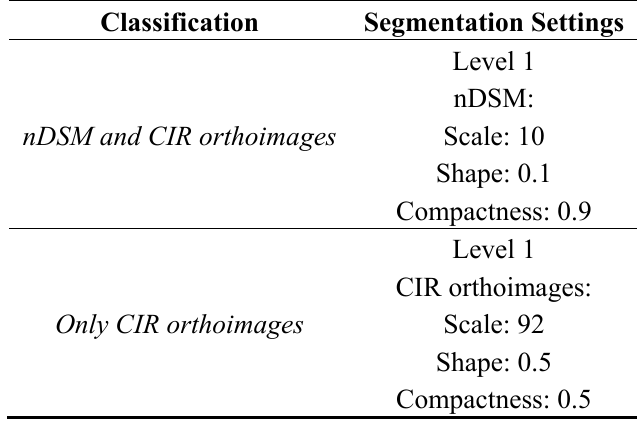
Table 1. Overview of the multiresolution settings used for segmentation of the nDSM and the CIR